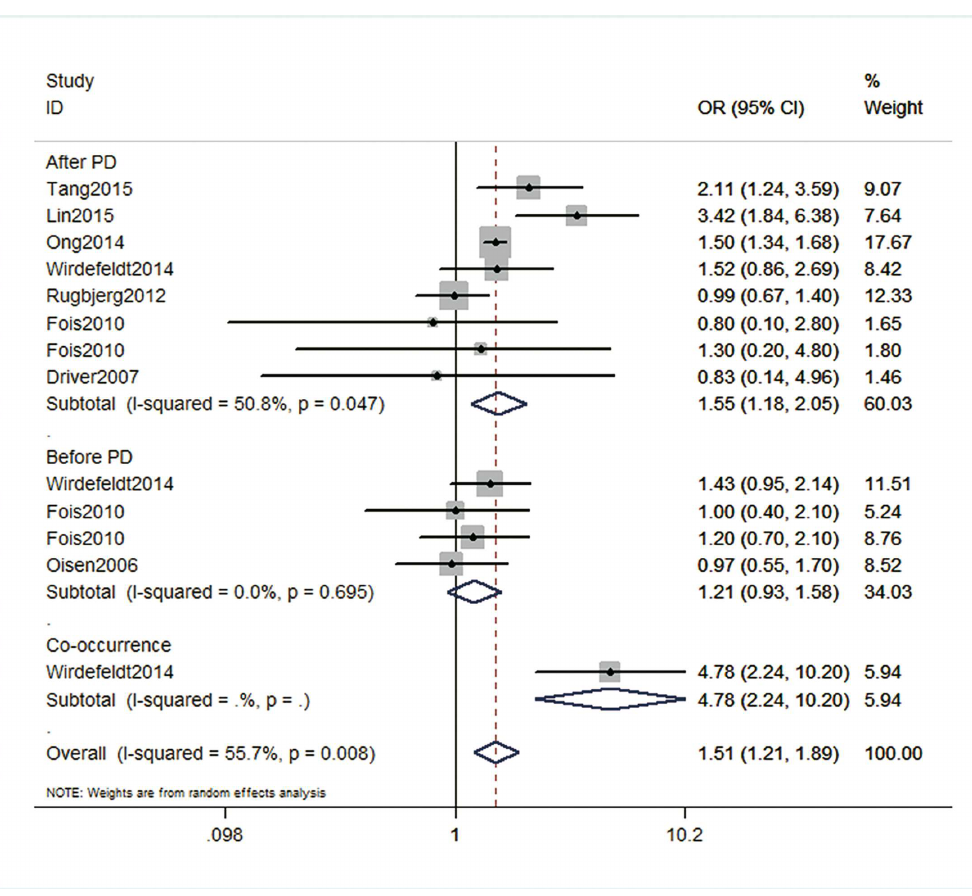
Fig 2. Forest plot of ORs for risk of brain tumor among PD patients. (OR 1.51, 95%CI 1.21–1.89, p < 0.001, heterogeneity I 2 = 55.7%, p = 0.008) and subgrouped by PD diagnosistime (brain tumor risk before PD, after PD or